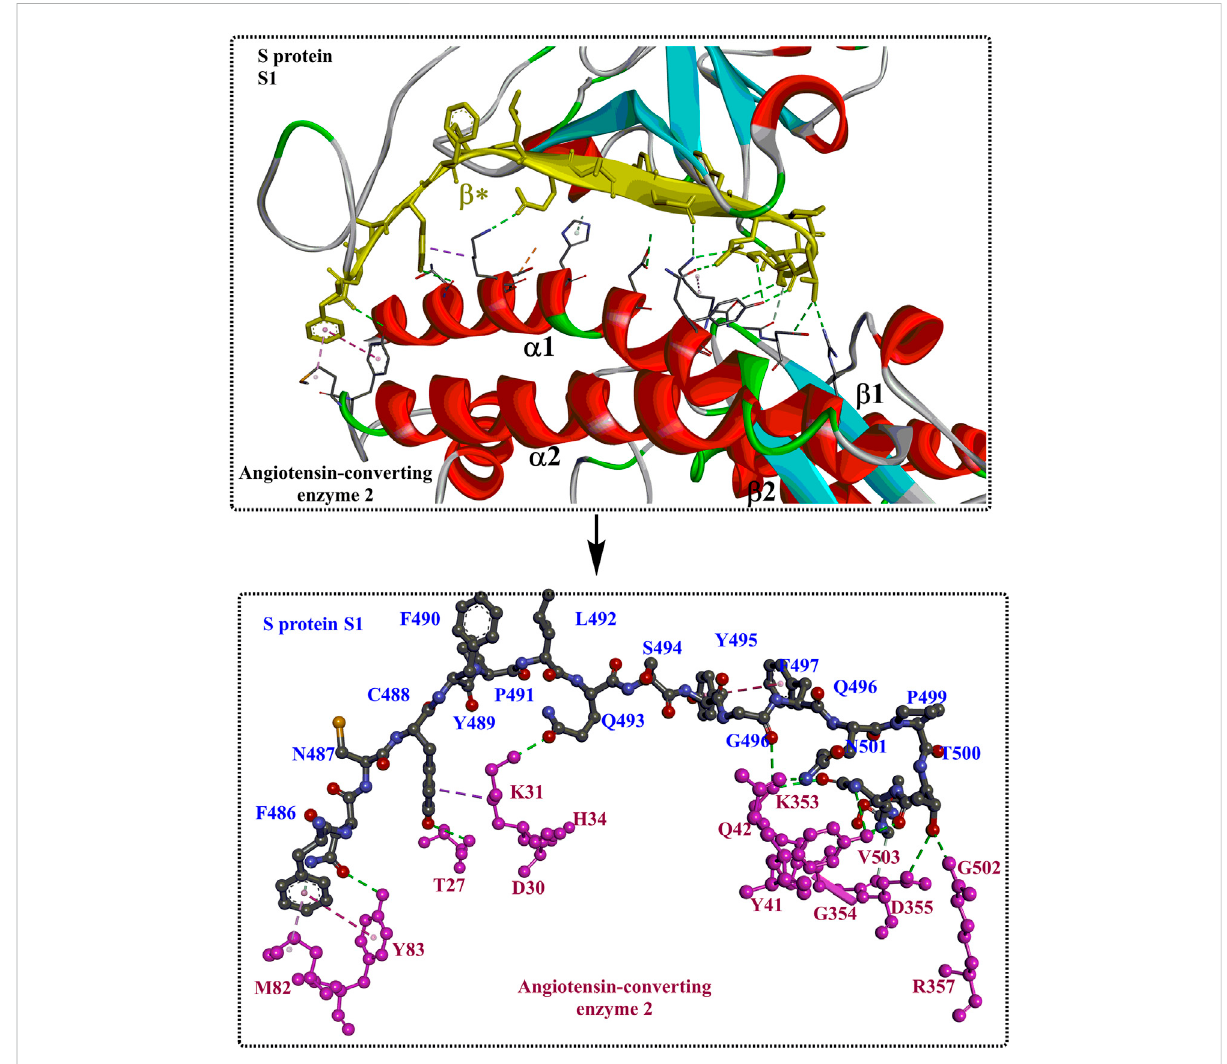
FIGURE 4 The interaction modes of S1 and ACE2 (PDB ID: